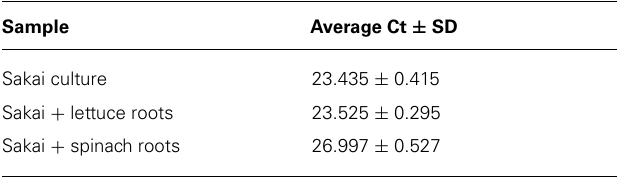
Table 1 | Comparison of Ct values from E. coli O157:H7 isolate Sakai for an in vitro culture and for infected plant